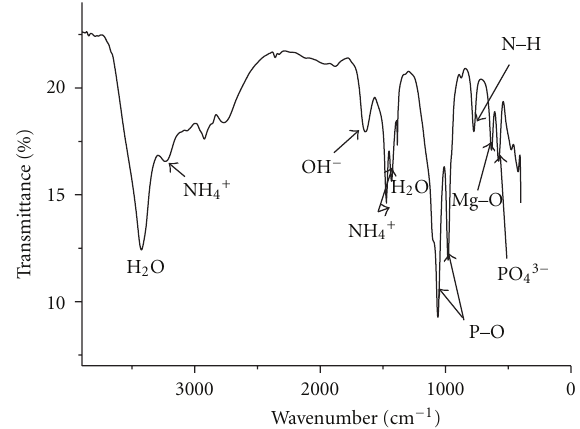
Figure 3: FT-IR spectrum of the as-prepared dittmarite.